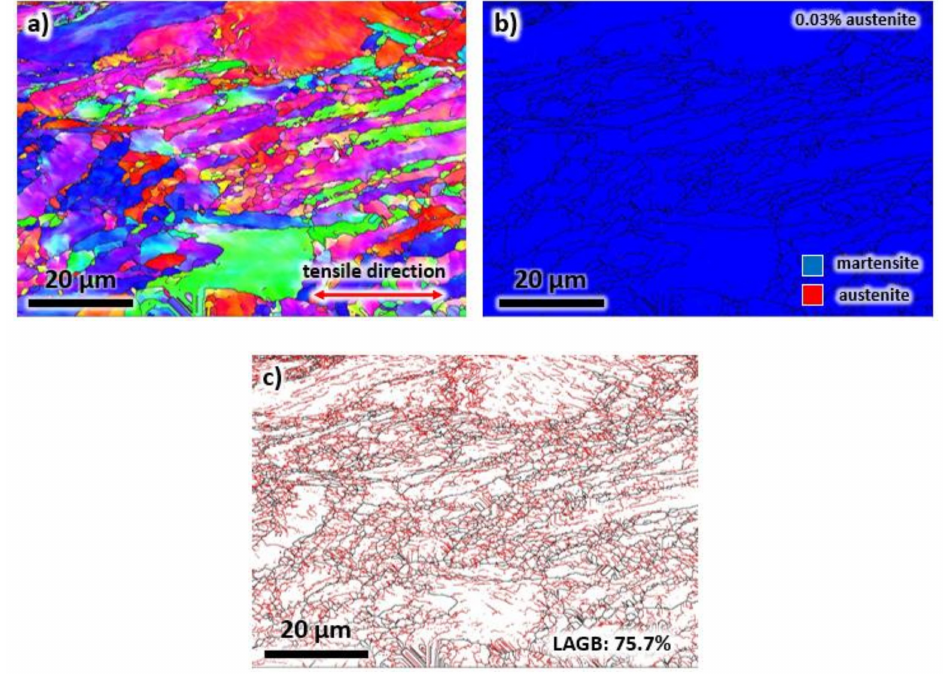
Figure 13. The ( a ) EBSD map, ( b ) phase map, and ( c ) grain boundary map of the heat-printed sample after tensile testing taken from the building direction.